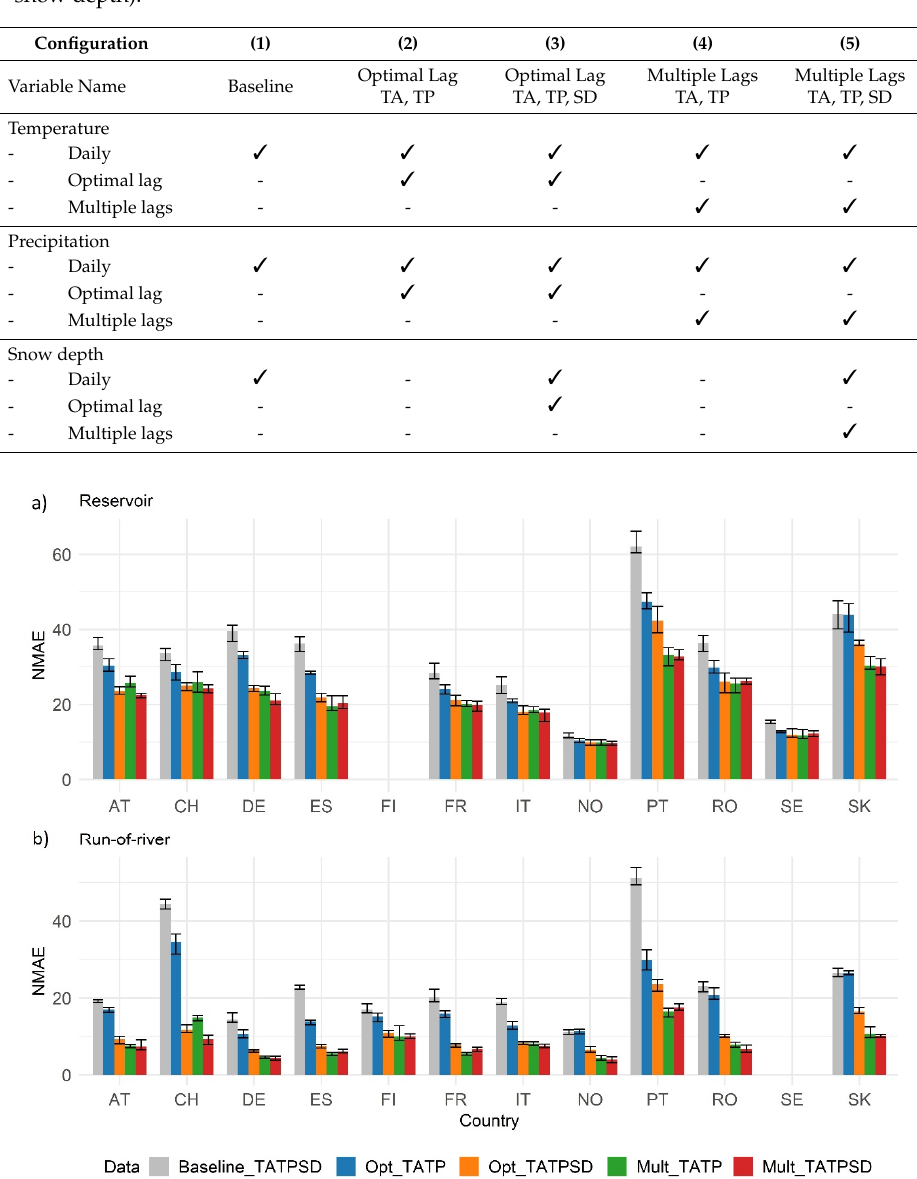
Figure 2. The normalised mean absolute error and 95% confidence interval for reservoir ( a ) and run-of-river ( b ) types of the five models using inputs from k-fold cross-validation as follows: (1) baseline with daily temperature, precipitation, and snow depth in grey; (2) optimal lag of temperature and precipitation in blue; (3) same as second model + optimal lag of snow depth in orange; (4) multiple lags of temperature and precipitation in green (selected model); (5) same as (4) + multiple lags of snow depth in red. (TA = 2 metre temperature, TP = precipitation, and SD = snow depth.) Table 3. Statistical significance test between model configurations with and without snow depth (see Figure 2 for abbreviations used). The results are divided into three categories based on p-value: significantly different (p < 10 –3 in red), different (10 –3 < p < 0.05 in orange), and not different (p > 0.05 in pale yellow). The white colour indicates no available data.